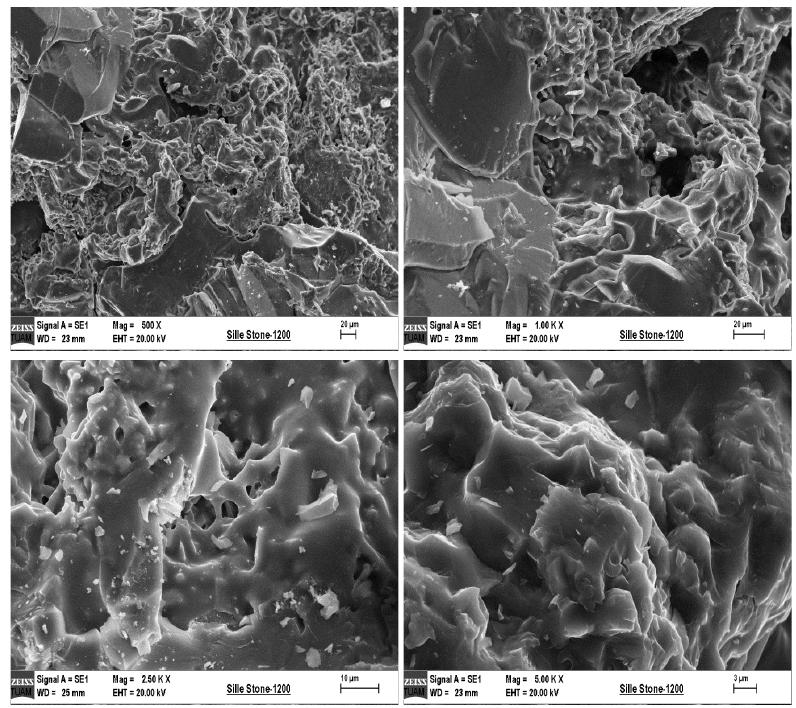
Figure 9. SEM micrographs of heat treated-Sille stone at 1200 °C Figure 9: SEM micrographs of heat treated-Sille stone at